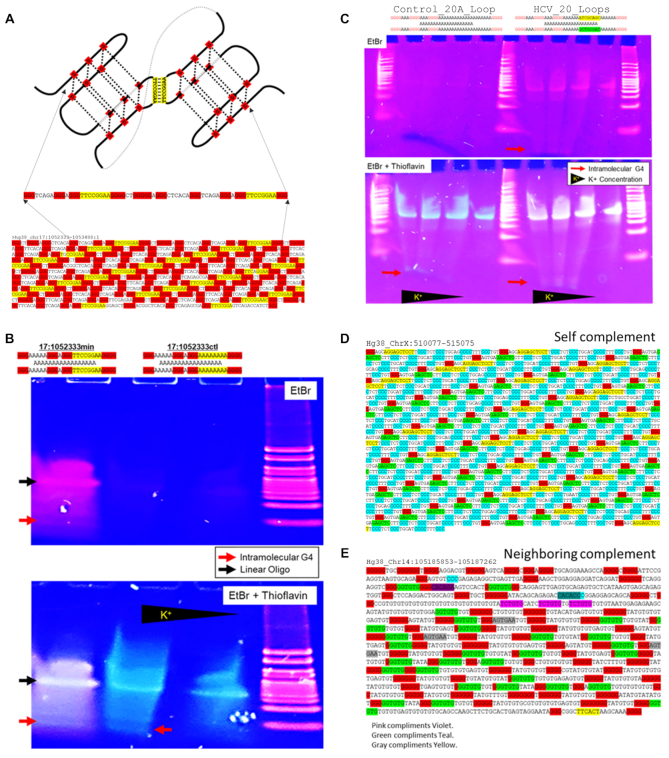
LG4 Kissing Loops. (A) Predicted model of neighboring G4 loop interaction in human LG4 locus occurring at hg38:chr17:1052333–1053488 is illustrated. Complementary loops are highlighted in yellow. Guanine triplets are highlighted in red. (B) Nondenaturing G4 gel electrophoresis of minimal G4 capable sequence (taken from the LG4 detailed in A). Lane 1 – tandem of two minimal G4 capable sequences with complementary loops. Lanes 2 and 3 – tandem of two minimal G4 capable sequences with complementary loops replaced by adenosines. Upper gel image: EtBr stain (orange) only. The affinity for EtBr binding of dsDNA is ∼25 times its affinity for ssDNA. Lower gel image: Subsequent Thioflavin (blue) staining of the identical gel shown in the upper image. (C) Nondenaturing G4 gel electrophoresis of G4 capable sequences with complementary loops from known HPV kissing hairpins. (Left) Control oligonucleotide lacking complementary loops. (Right) Oligonucleotide containing complementary loops known to participate in HCV hairpin kissing (111). Upper gel image: EtBr stain (orange) only. Lower gel image: Subsequent Thioflavin (blue) staining of the identical gel shown in the upper image. (D) Additional example of a LG4 locus with loops described as ‘Self complements’ (like the LG4 in A). (E) Example of a LG4 locus with loops described as ‘Neighboring complements’.